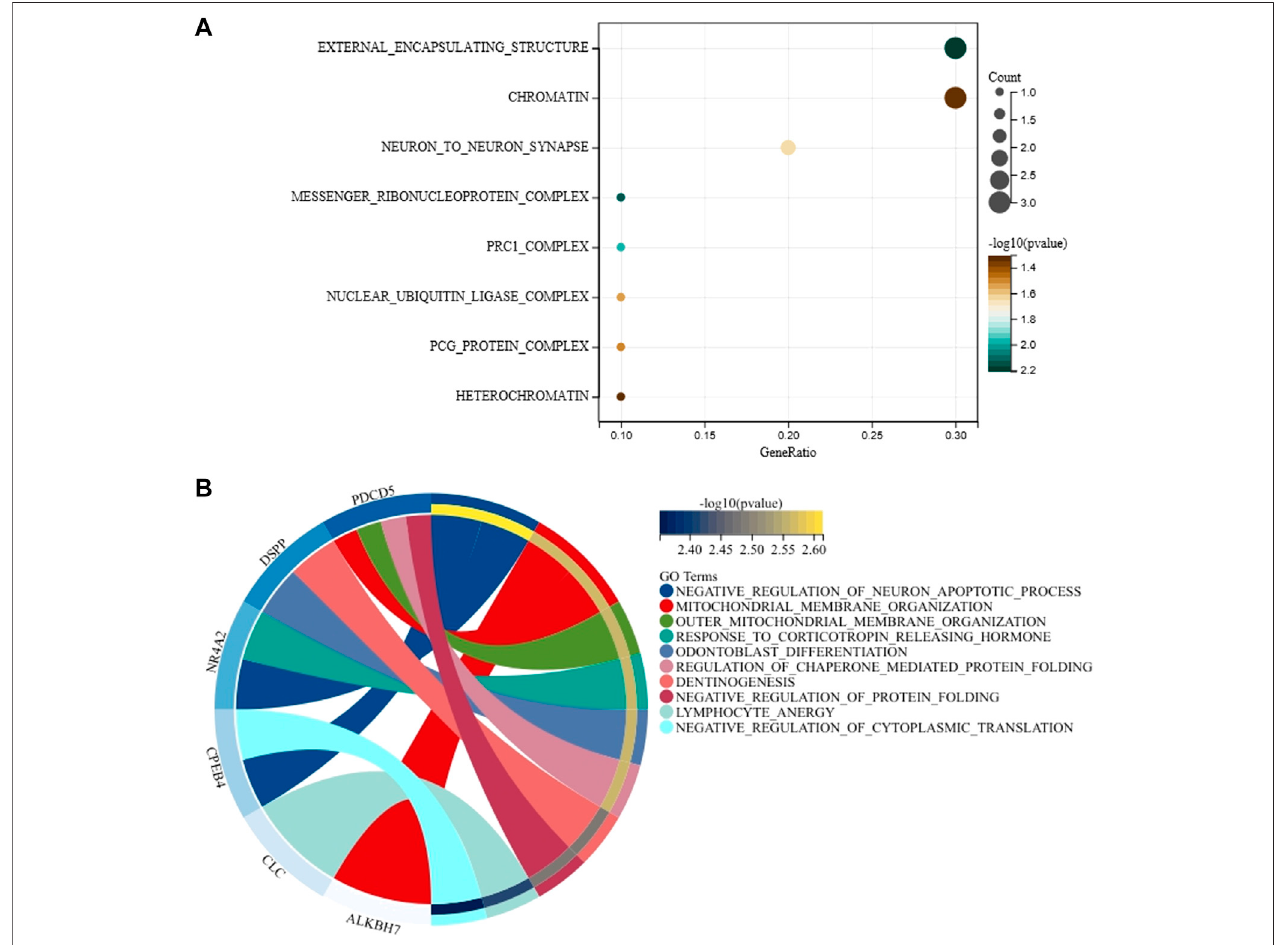
FIGURE 4 | Gene ontology analysis for cellular components (A) and biological processes (B) of 14 genes associated with age.